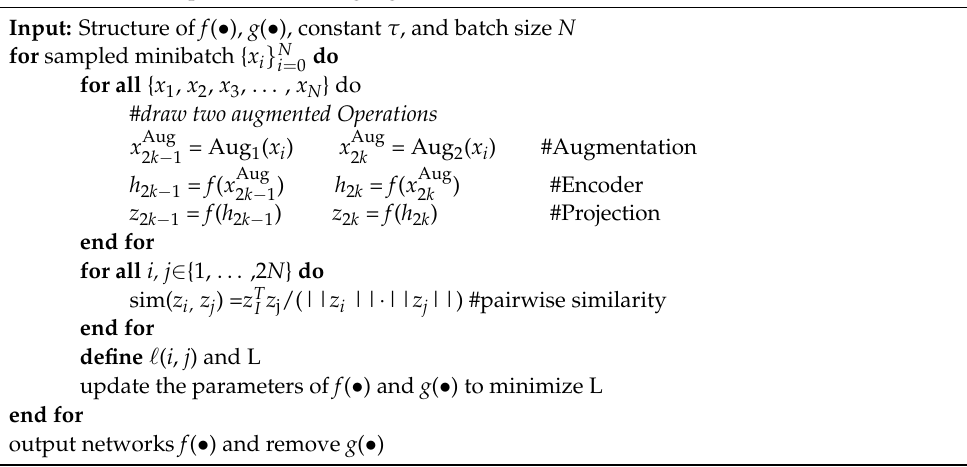
Algorithm 1. The pre-train learning algorithm of